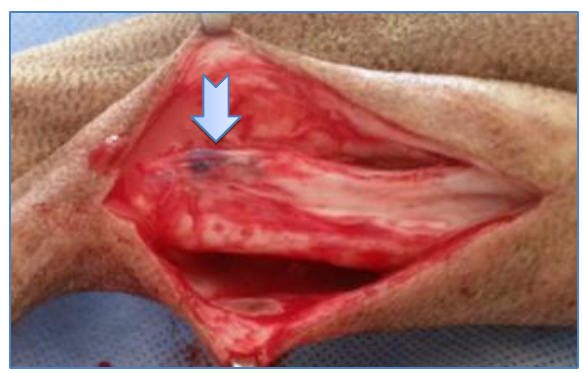
Figure, 6: Shows the adhesion in second group, 2 months post-implantation.